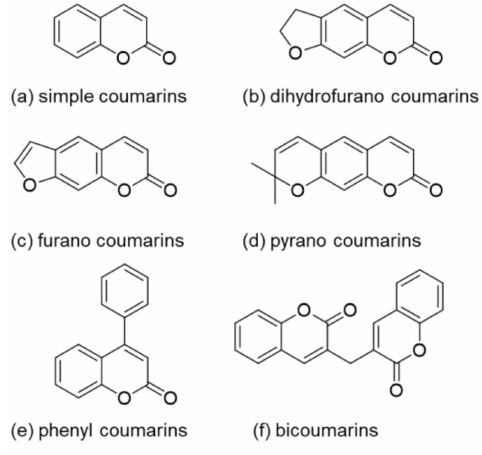
Figure 1. Structures of the different coumarin classes.